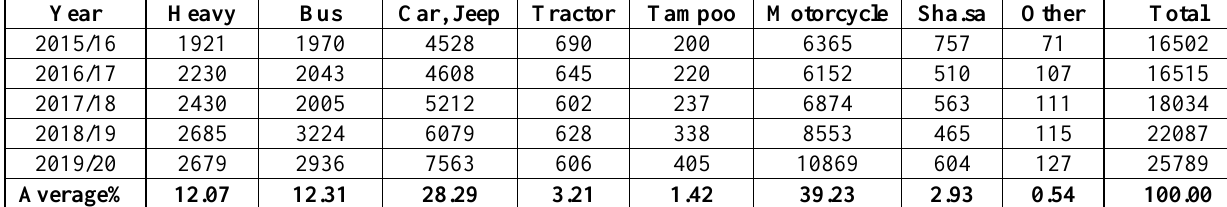
Table 24: Involvement of vehicle in